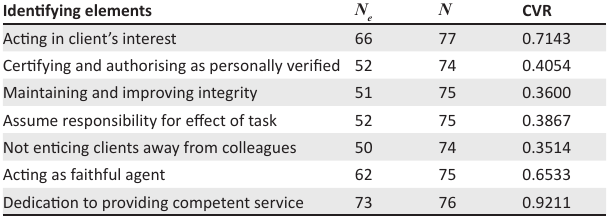
TABLE 10: Content Validity Ratio (Lawshe) of responsibility towards client or